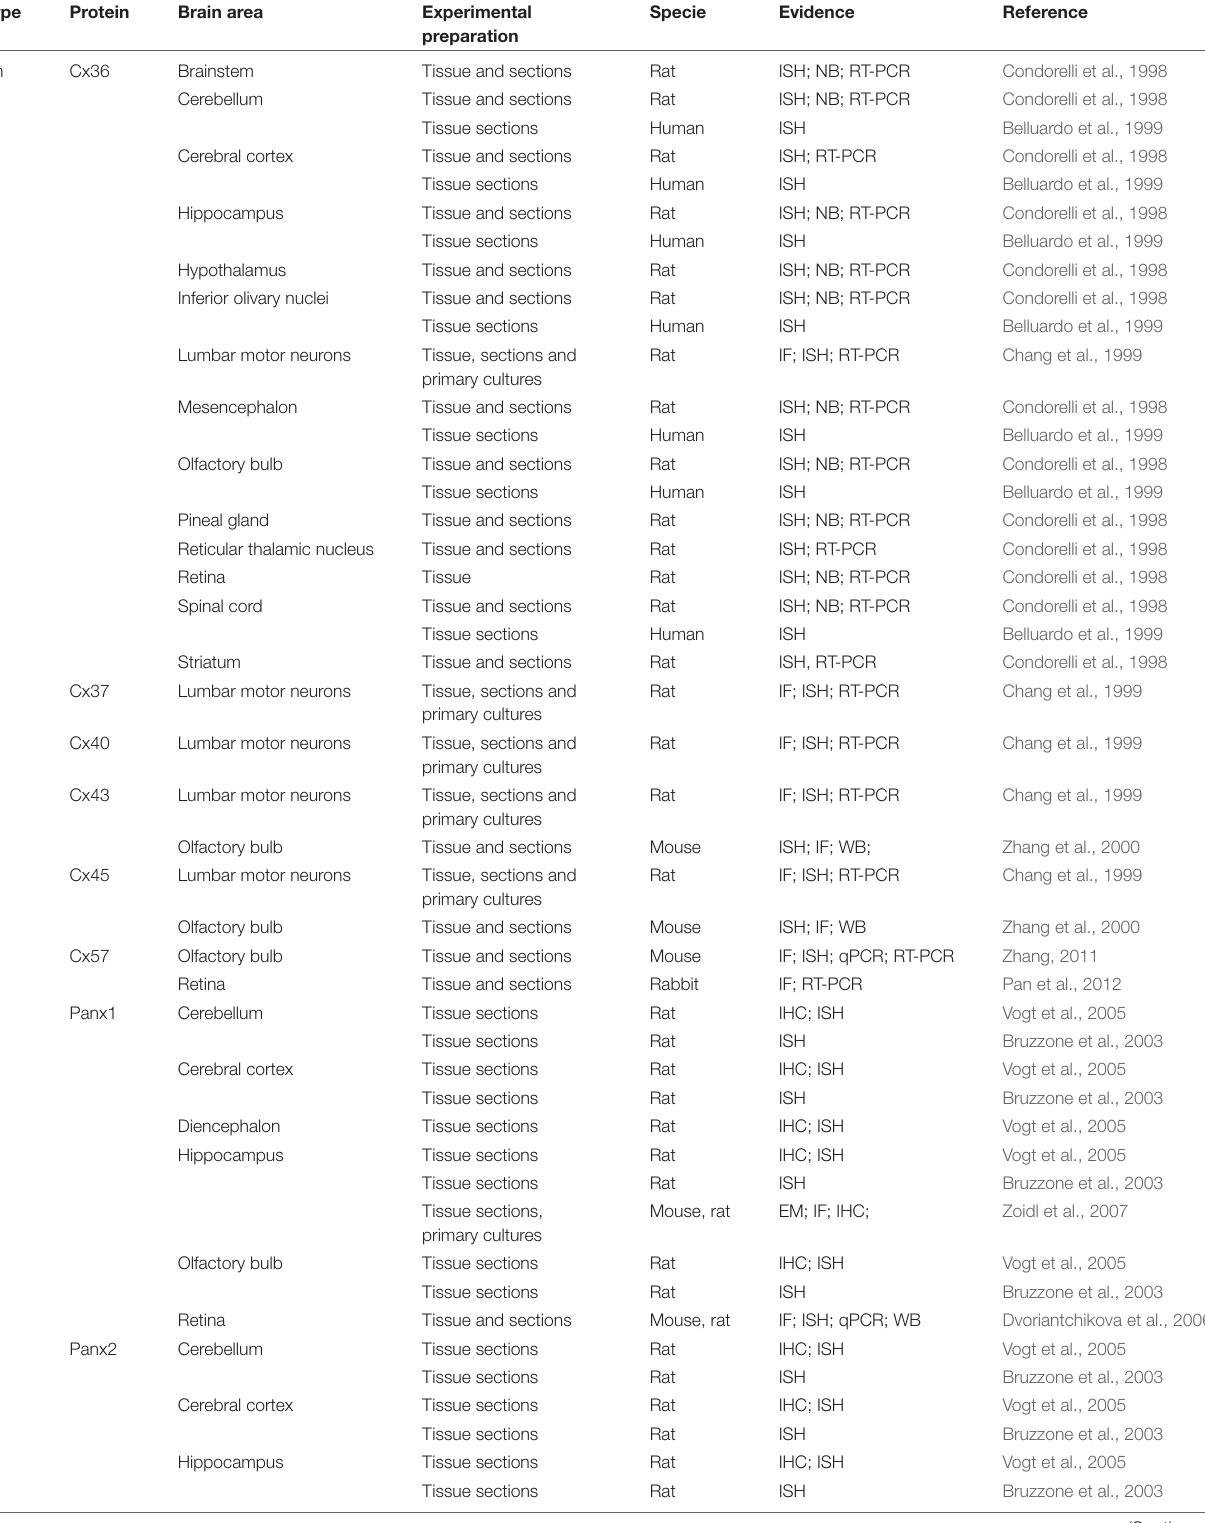
TABLE 1 | Brief summary of connexin and pannexin expression in the nervous system ∗ . Cell